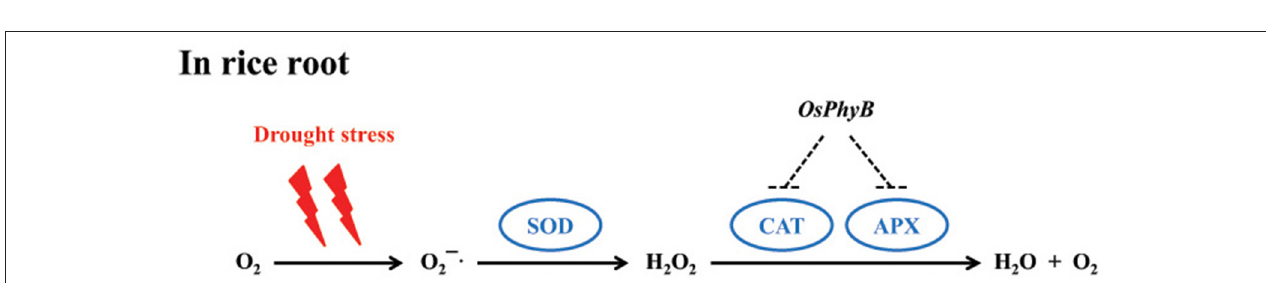
FIGURE 10 | Scavenging model of reactive oxygen species (ROS) in rice roots under drought stresses. APX and CAT, which play a key role in ROS scavenging, are thought to be regulated by phyB